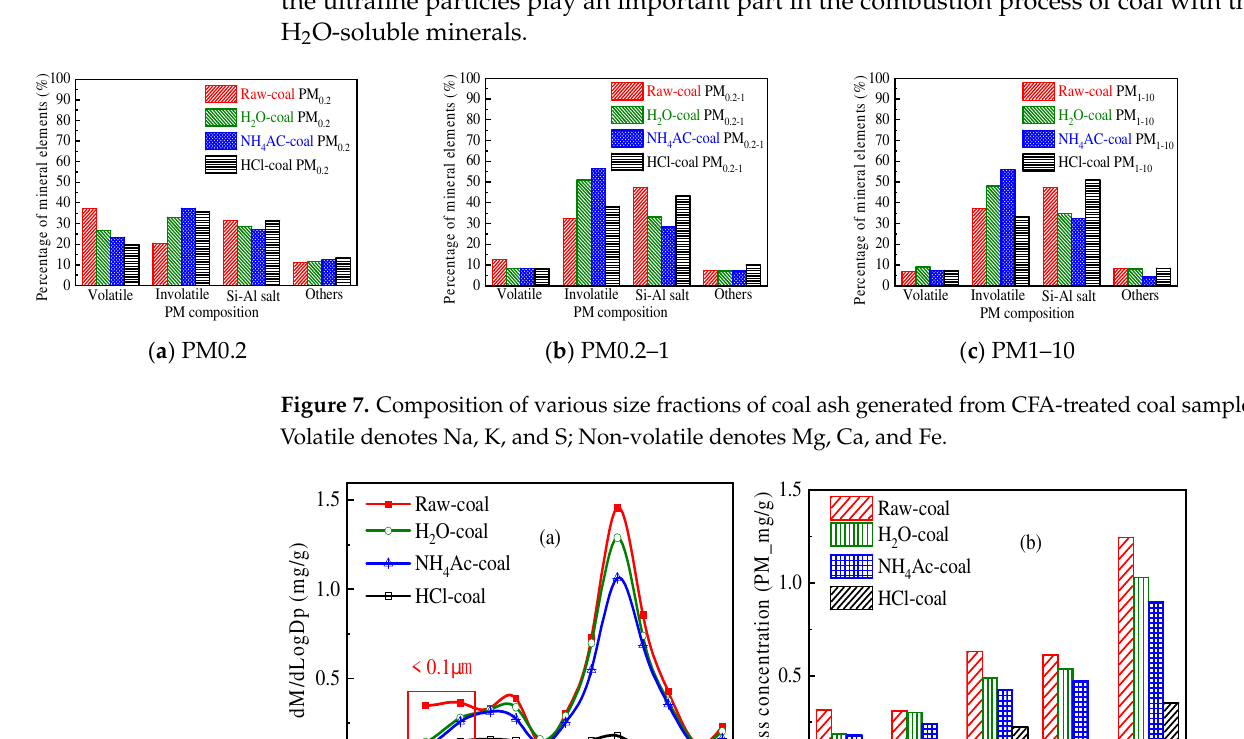
Figure 6. Major mineral in PM10 from CFA-treated coal samples.